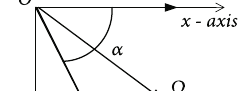
Table 1: Aerodynamic reference dimensions and mass